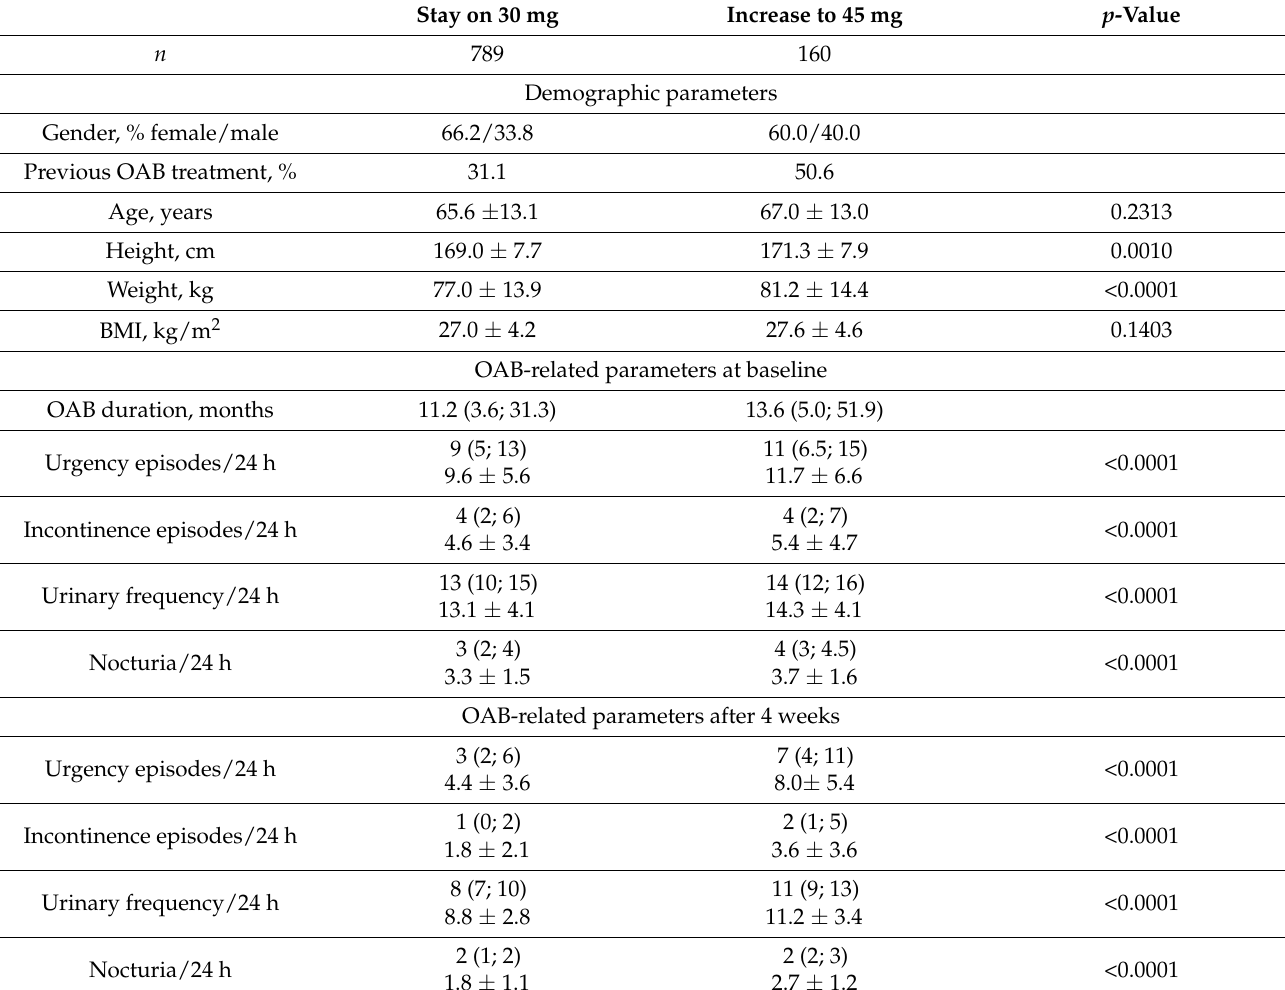
Table 3. Demographic and OAB-related baseline variables and after 4 weeks in patients starting treatment with a propiverine dose of 30 mg/d and either staying on that dose after 4 weeks or increasing it 45